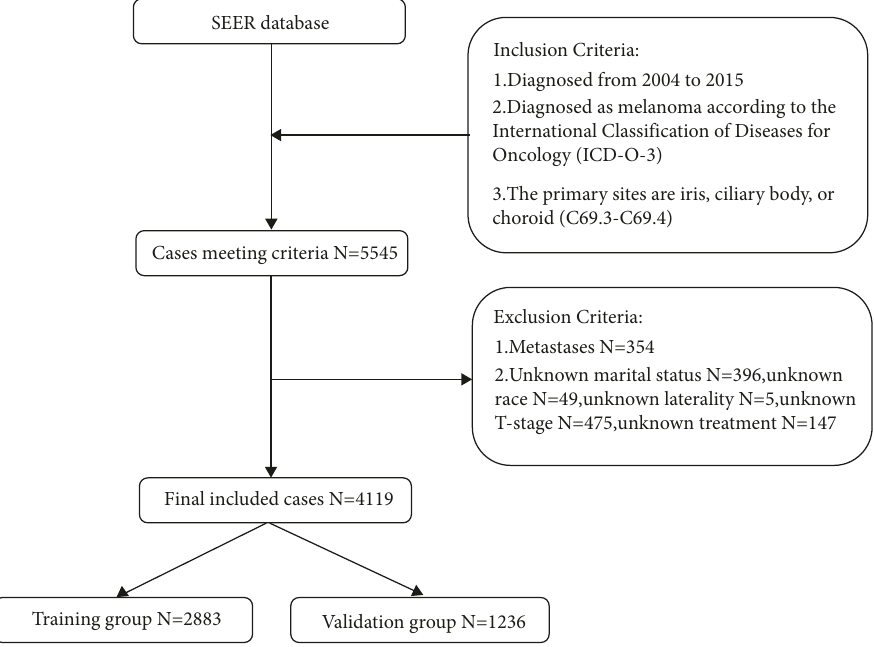
Figure 1: Flow chart of case selection